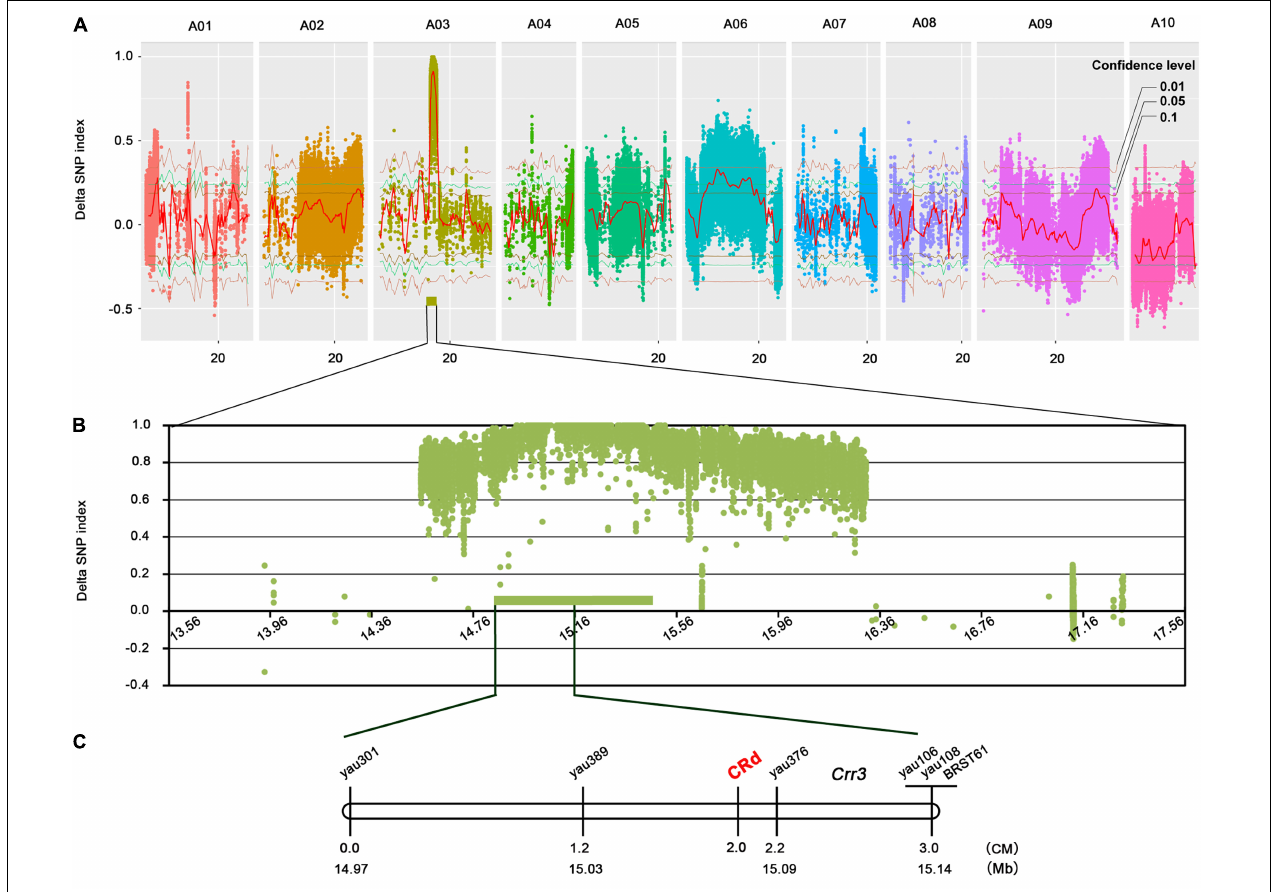
FIGURE 2 | CRd mapping by NGS-based BSA and genetic mapping approaches. (A) Genome-wide (cid:49) SNP index Manhattan plots and marker-trait association with 0.1, 0.05, and 0.01 confidence levels. (B) (cid:49) SNP index Manhattan plots in candidate region; the green rectangle indicates the core region. (C) Genetic/physical map of the region harboring CRd on chromosome